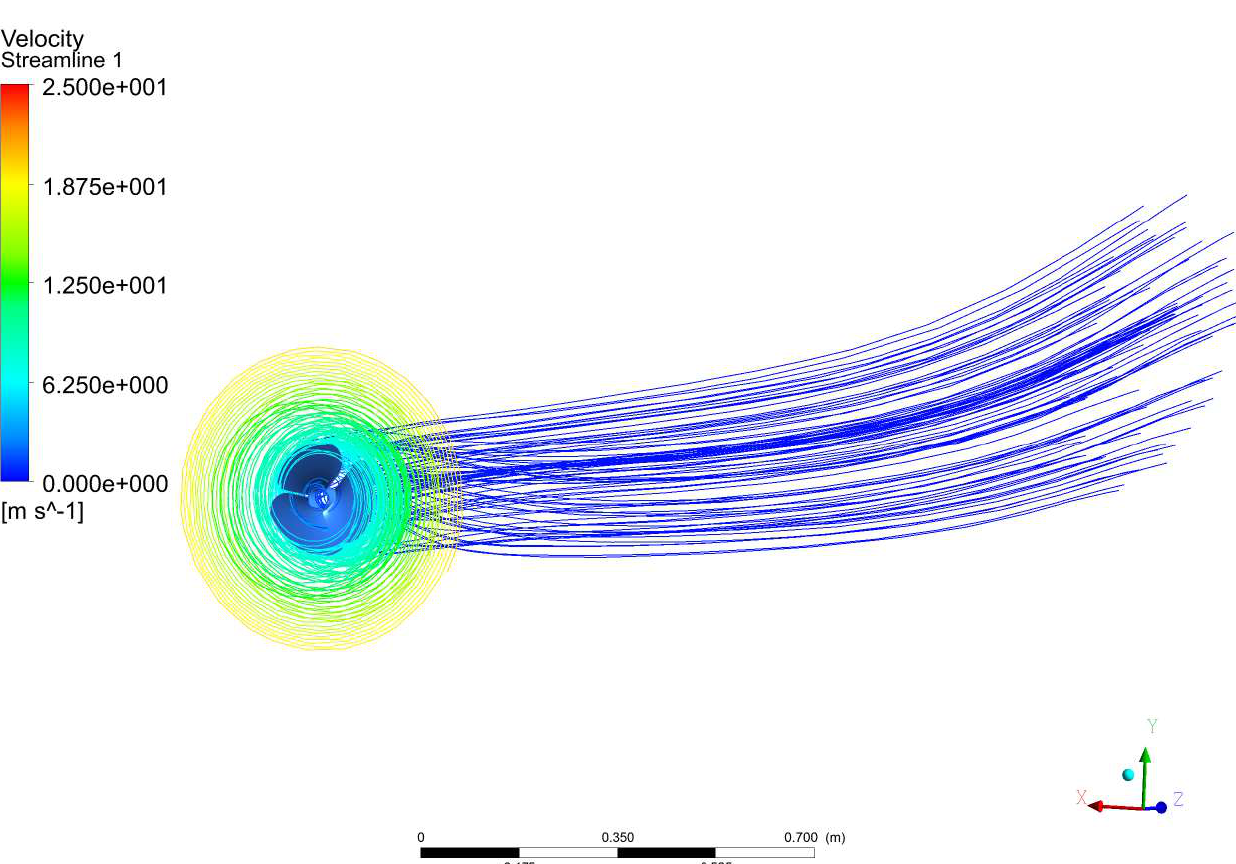
Figure 19. Velocity variations of 500 RPM.